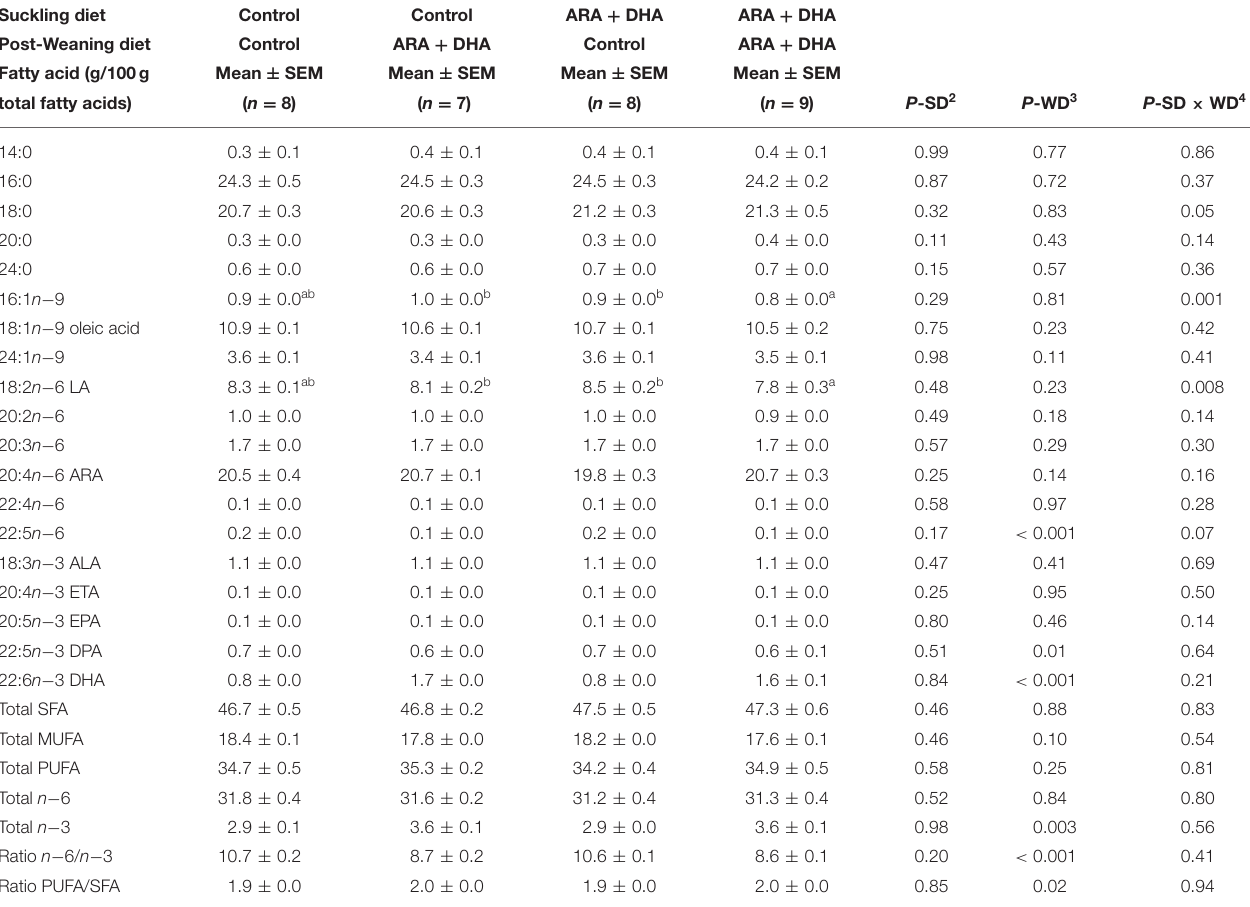
TABLE 3 | The effect of supplementing suckling diet and post-weaning diet on the total fatty acid composition in phospholipids of splenocytes of pups at 8 weeks 1 . Suckling diet Control Control Post-Weaning diet Control ARA + DHA Control ARA +